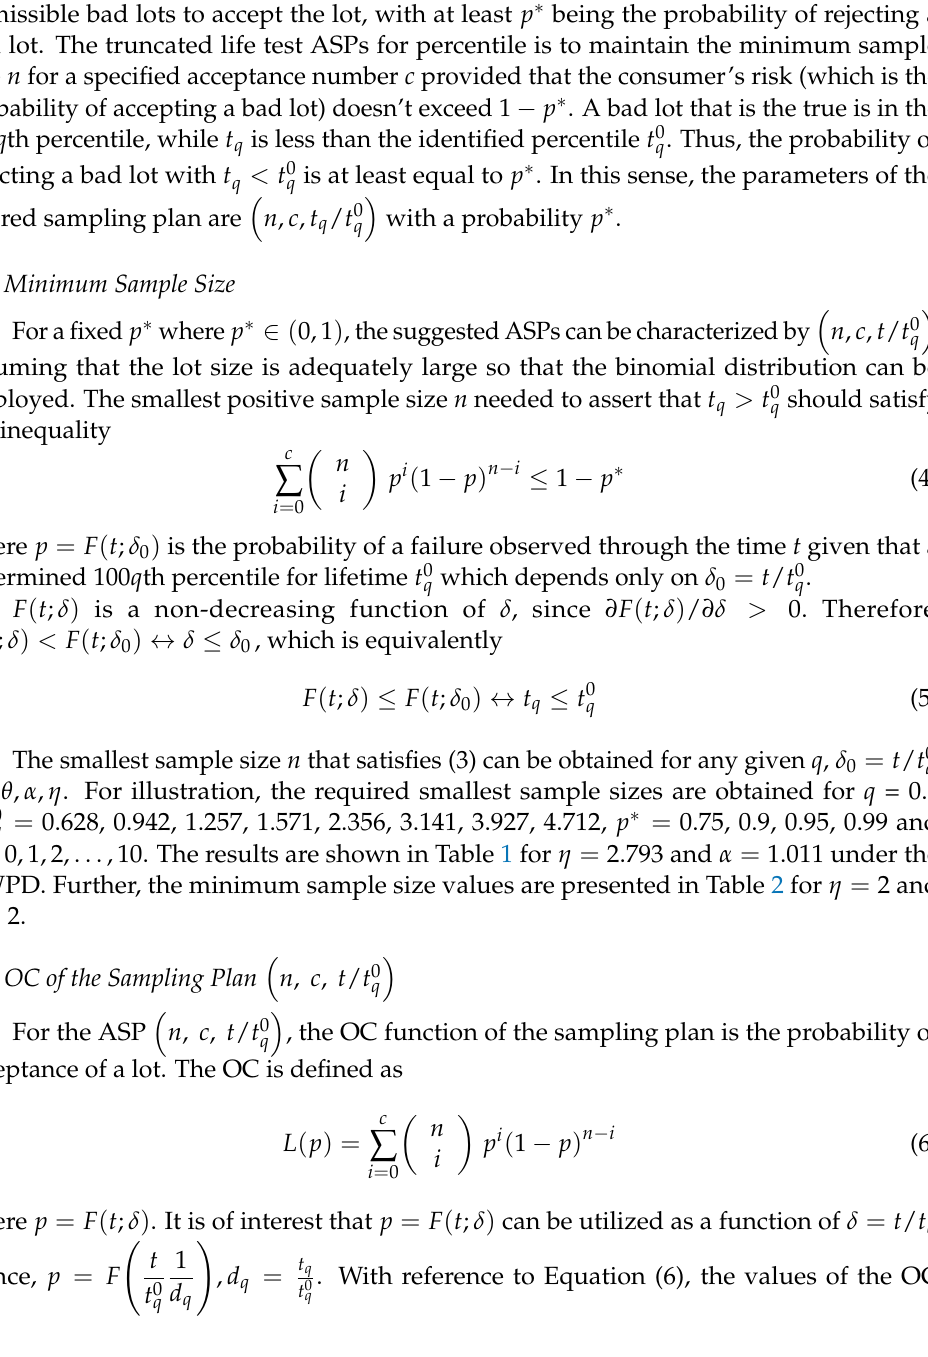
Figure 2. The hazard and distribution functions of the NWPD with η = 2, θ = 4.